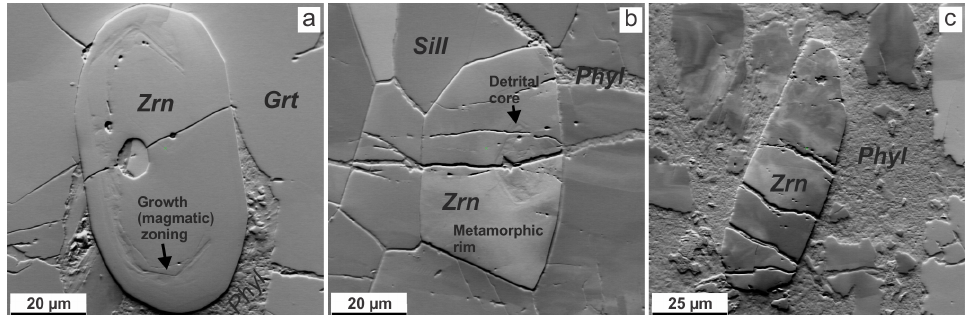
Figure 2. Orientation contrast images of detrital zircon in the sampled gneiss: (a) zircon grain hosted by garnet; note the concentric growth zoning. (b) Zircon grain hosted by sillimanite, note the small detrital core (right hand side) and wide metamorphic rim. (c) Zircon grain hosted by a fine-grained matrix that fills the veins; note intensive change in orientation contrast, especially conspicuous in the upper part of the grain. Orientation contrast image indicates the crystal-plastic deformation of the zircon grain and surrounding mineral fragments (garnet and sillimanite). Fracture surfaces appear to be dissolved. Mineral abbreviations as in Fig. 1. Table 2. Results of the microprobe analyses of the Fe–Ti oxides, n.d.: not detected. Ilm: ilmenite and Rut: rutile.